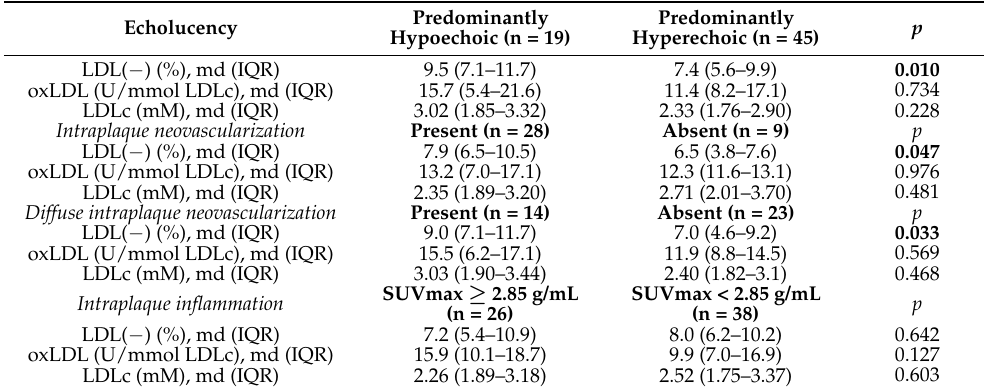
Table 2. LDL( − ), oxLDL, and LDLc levels by characteristics of plaque